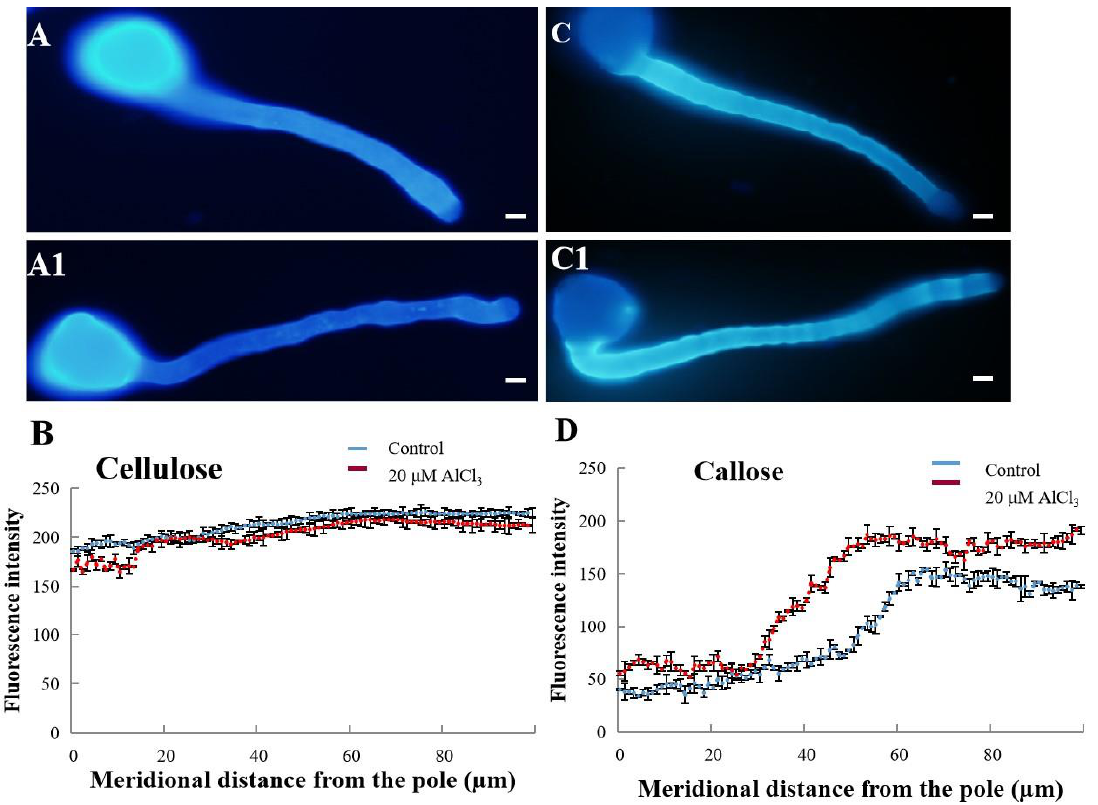
Figure 4. Effect of 20 µ M AlCl 3 on cellulose and callose of M. domestica pollen tubes. ( A ) Cellulose distribution in control pollen tube labeled with Calcofluor White Stain under fluorescence microscope. ( A1 ) Cellulose of pollen tube treated with 20 µ M AlCl 3 . ( B ) Quantitative analysis of the fluorescent intensity of cellulose in the wall of control pollen tubes (blue line) and 20 µ M AlCl 3 treated pollen tubes (red line). ( C ) Callose distribution in control pollen tube labeled with aniline blue under fluorescence microscope. ( C1 ) Callose of pollen tube treated with 20 µ M AlCl 3 . ( D ) Quantitative analysis of the florescent intensity of callose in the wall of control (blue line) and 20 µ M AlCl 3 treated pollen tubes (red line). Arrows indicate the tips of pollen tubes. Bar = 10 µ m. 2.5. Effects of 20 µM AlCl 3 on Distribution of Pectins in Pollen Tube Cell Wall of M. domestica Acid pectins (JIM 5) was evenly distributed on the control pollen tube wall (Figure 5A1). At the tip of pollen tube wall, the fluorescent intensity of the 20-µM-AlCl 3 -treated pollen tubes became weaker, indicating that 20 µM AlCl 3 decreased acid pectins (Figure 5B1 and C). Esterified pectins (JIM 7) was distributed on both the control and 20-µM-AlCl 3 - treated pollen tube wall with strong fluorescence at the tip (Figure 5E1). Compared with the control pollen tube, stronger fluorescence was observed at the tip of the 20 μM AlCl 3 pollen tube (Figure 5F). Thus, 20 μM AlCl 3 increased esterified pectins in the pollen tubes.